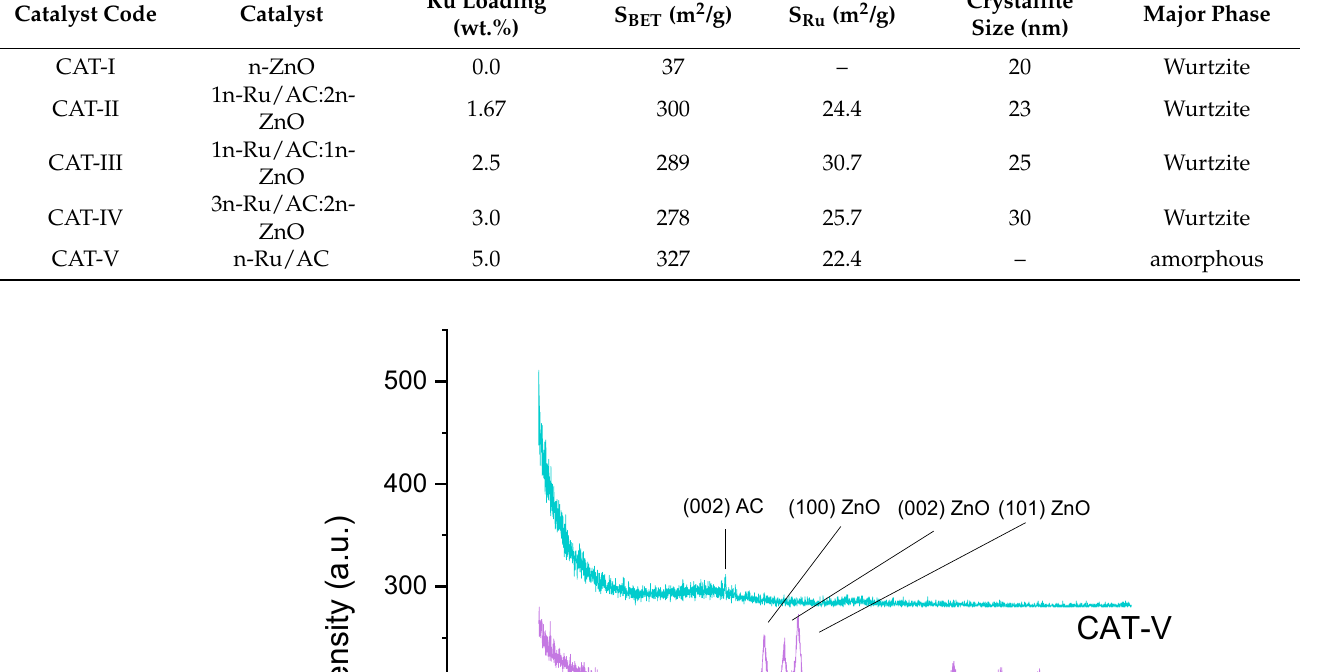
Table 1. Textural properties and characteristics of investigated catalysts.[6].